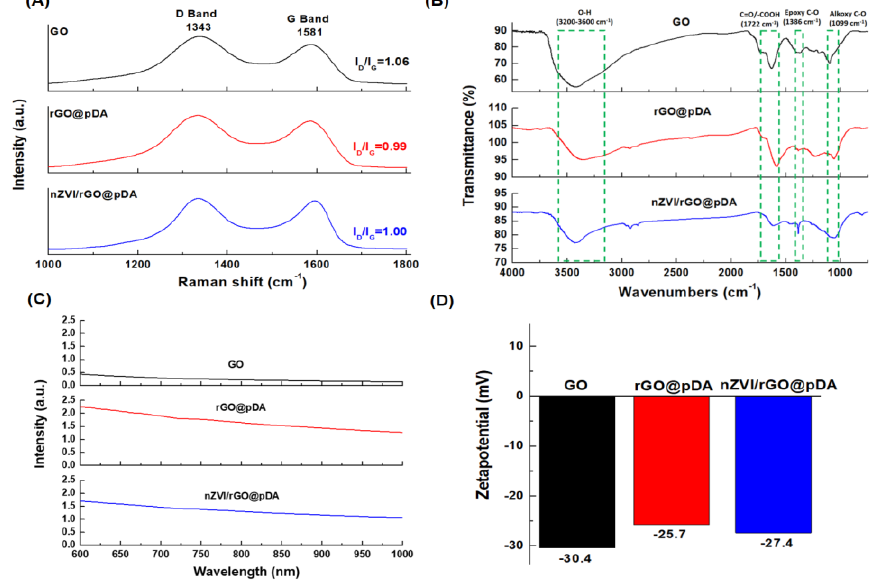
Figure 3. Physicochemical properties of nano zero-valent iron immobilized on the surface of reduced graphene oxide compared to modified with dopamine. ( A ) Raman spectra of prepared